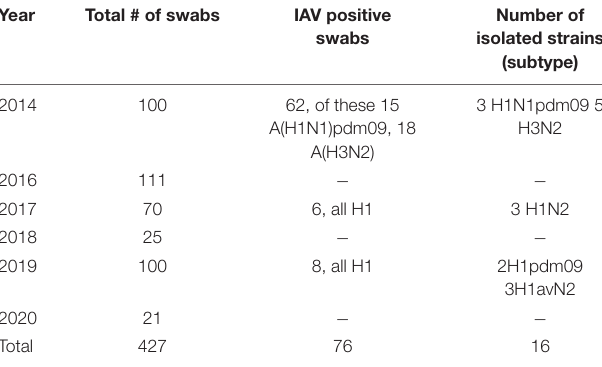
TABLE 2 | Number of influenza strains isolated from IAV-positive samples (by